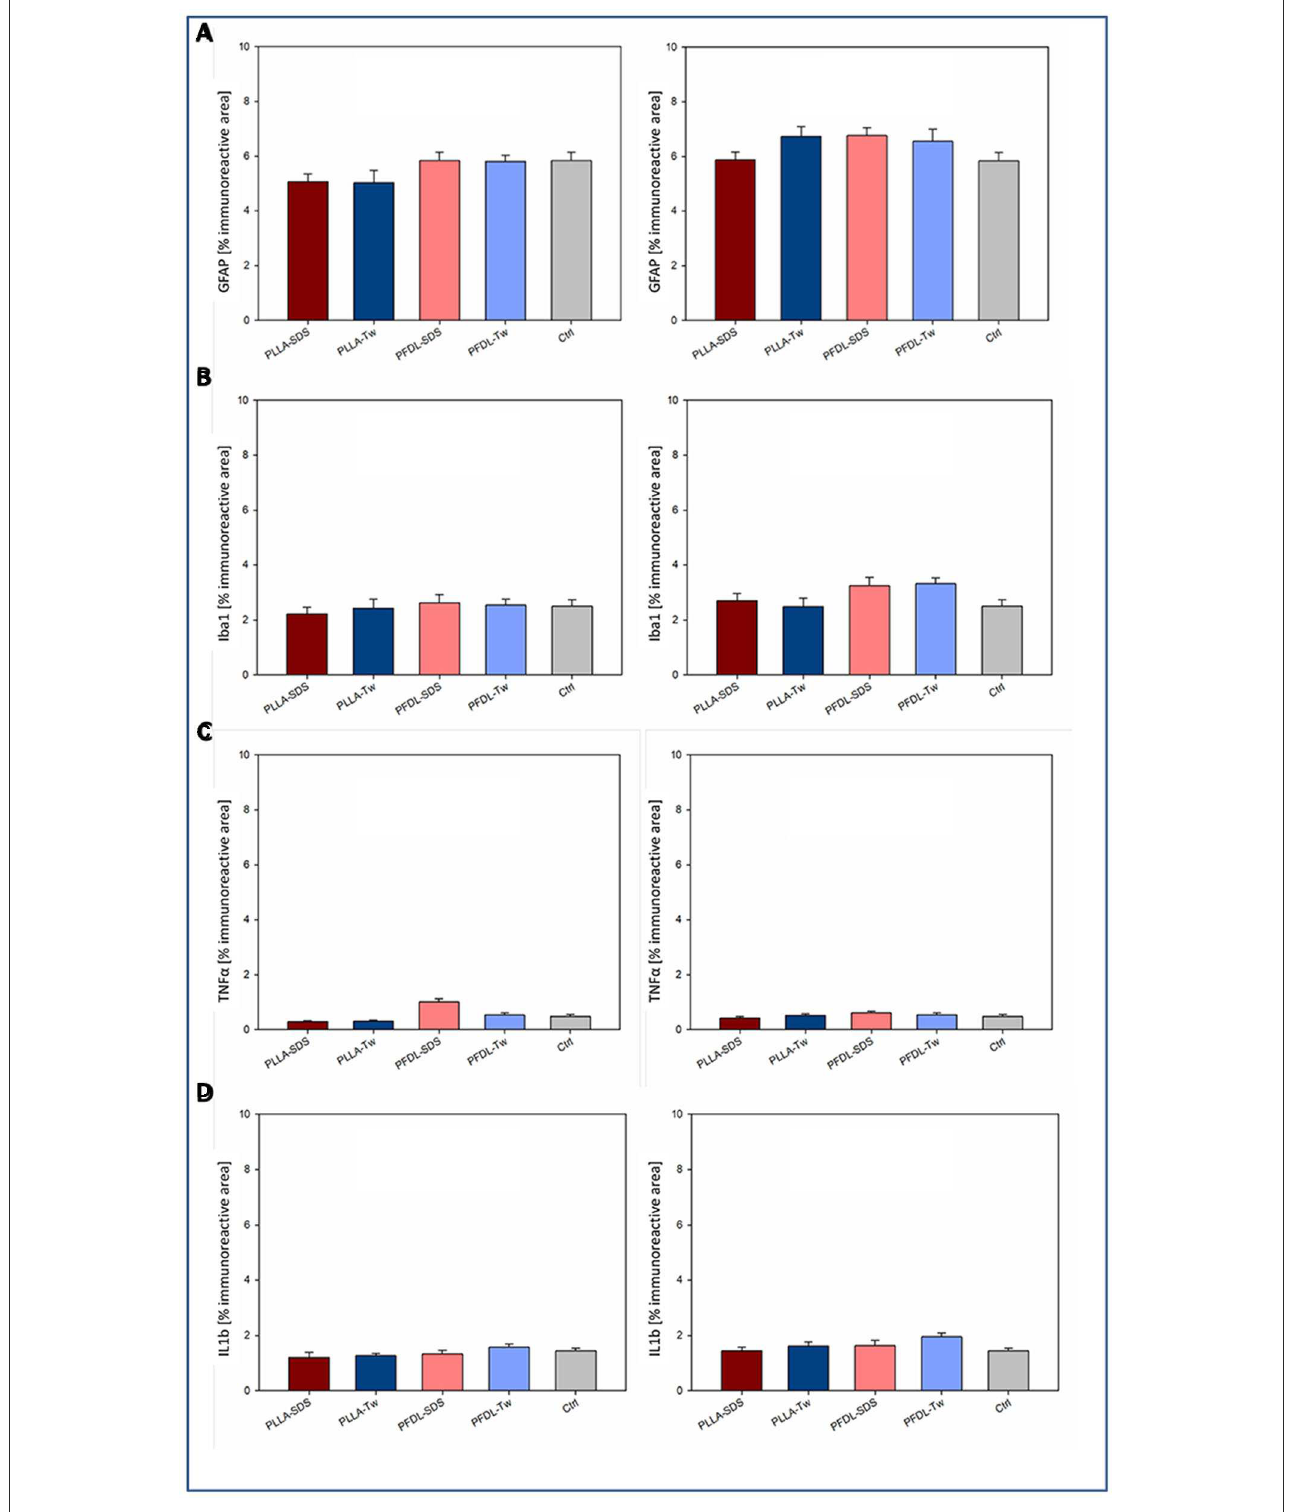
FIGURE11 Assessment of a neuroinflammatory reaction by intravenously injected NPs. Immunohistochemical staining against two markers of glial activation: GFAP (A) , Iba1 (B) ; and two proinflammatory cytokines: TNF α (C), and IL1 β (D) was compared between uninjured animals with and without NP injection at the survival timepoints of 4 and 24h. One-way ANOVAs showed no statistically significant differences in immunoreactive areas between groups. Bars express means ±